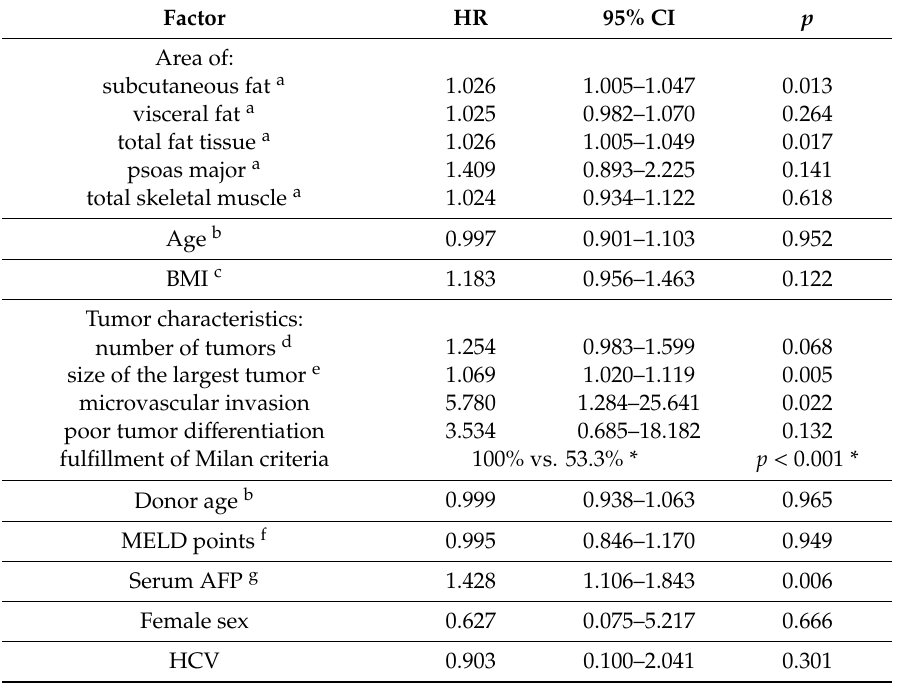
Table 3. Risk factors for tumor recurrence after liver transplantation for